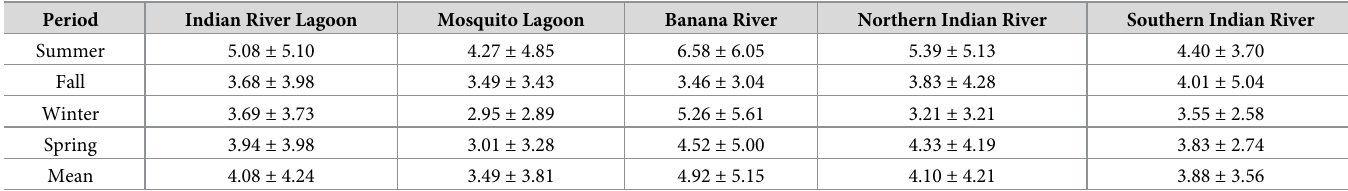
Table 1. Mean group size ( ± SD) of bottlenose dolphins in the Indian River Lagoon and its four sub-basins by primary period.